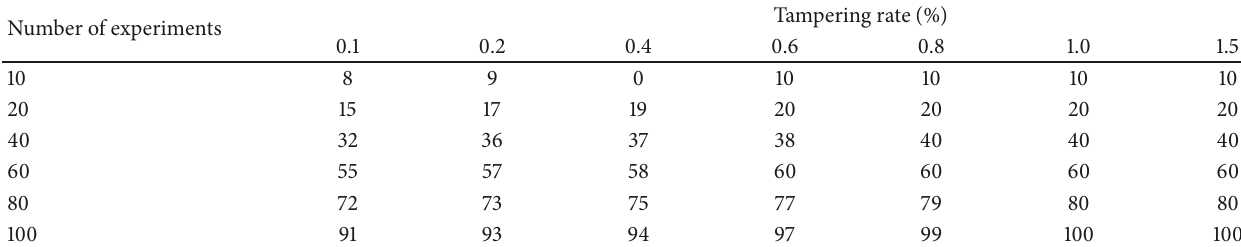
Table 3: The relationship between the proportion of tampered files and the efficiency of the algorithm. Number of experiments